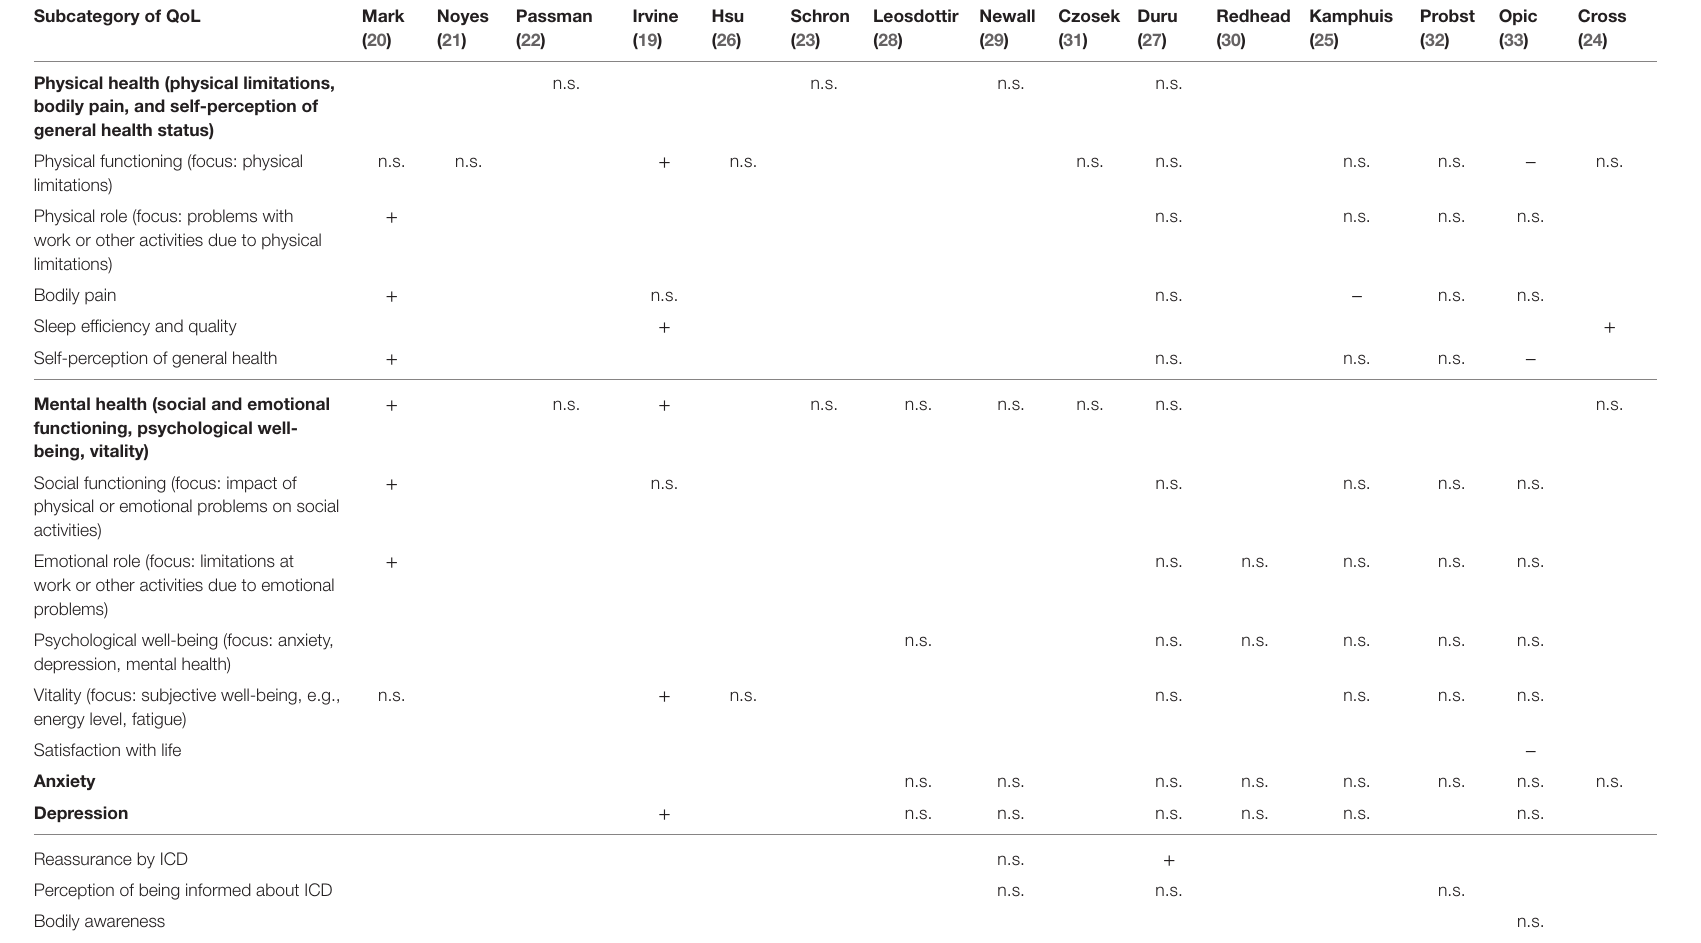
TABLe 4 | Findings from the included studies with respect to distinct subcategories of QoL. Subcategory of